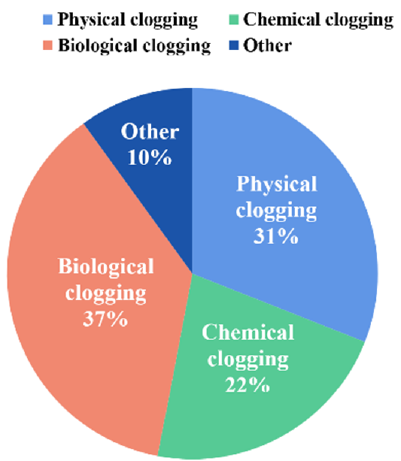
Figure 4. The types and probability of emitter clogging in drip irrigation. Date from the statistics of consultant from the Food and Agriculture Organization.